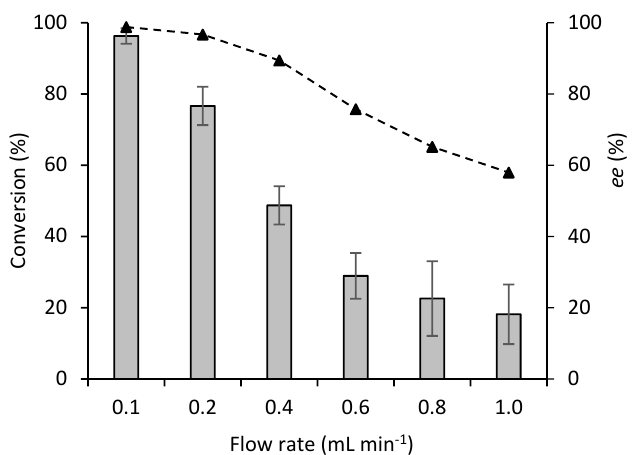
Figure 4. Synthesis of ( R )-mandelonitrile using wet At HNL-EziG Opal (10 U mg − 1 ) in a CFR. Immobilization was performed by adsorption. Conversion (bars), enantiomeric excess (dotted line and triangles). Conditions: benzaldehyde (0.5 M), HCN solution in citrate/phosphate buffered MTBE (1.5–2 M) pH 5, 1,3,5-triisopropylbenzene (50 mM, I.S.), a CFR with At HNL immobilized on 150 mg EziG Opal. Mol ratio of monomeric At HNL:Fe 3+ was 1:4. Reactions were performed at room temperature. Error bars correspond to the standard deviation of triplicates ( n = 3).